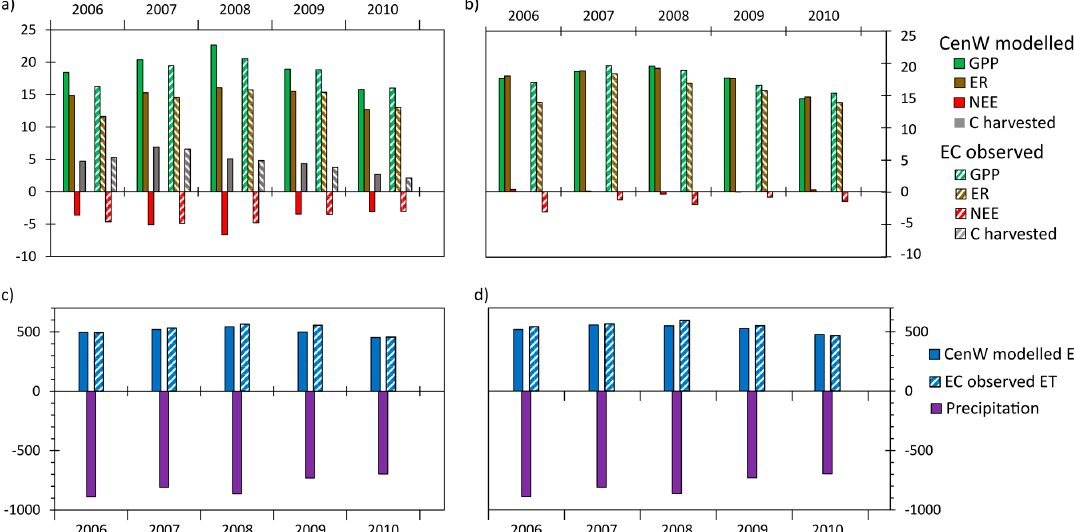
Figure 11. Bar plot showing modeled and observed annual CO 2 and water balances for the mowed (( a ) and ( c )) and grazed (( b ) and ( d )) paddocks. Carbon fluxes (NEE, GPP, ER, and C harvested are given in tC ha − 1 and precipitation and ET are given in mm yr − 1 ).